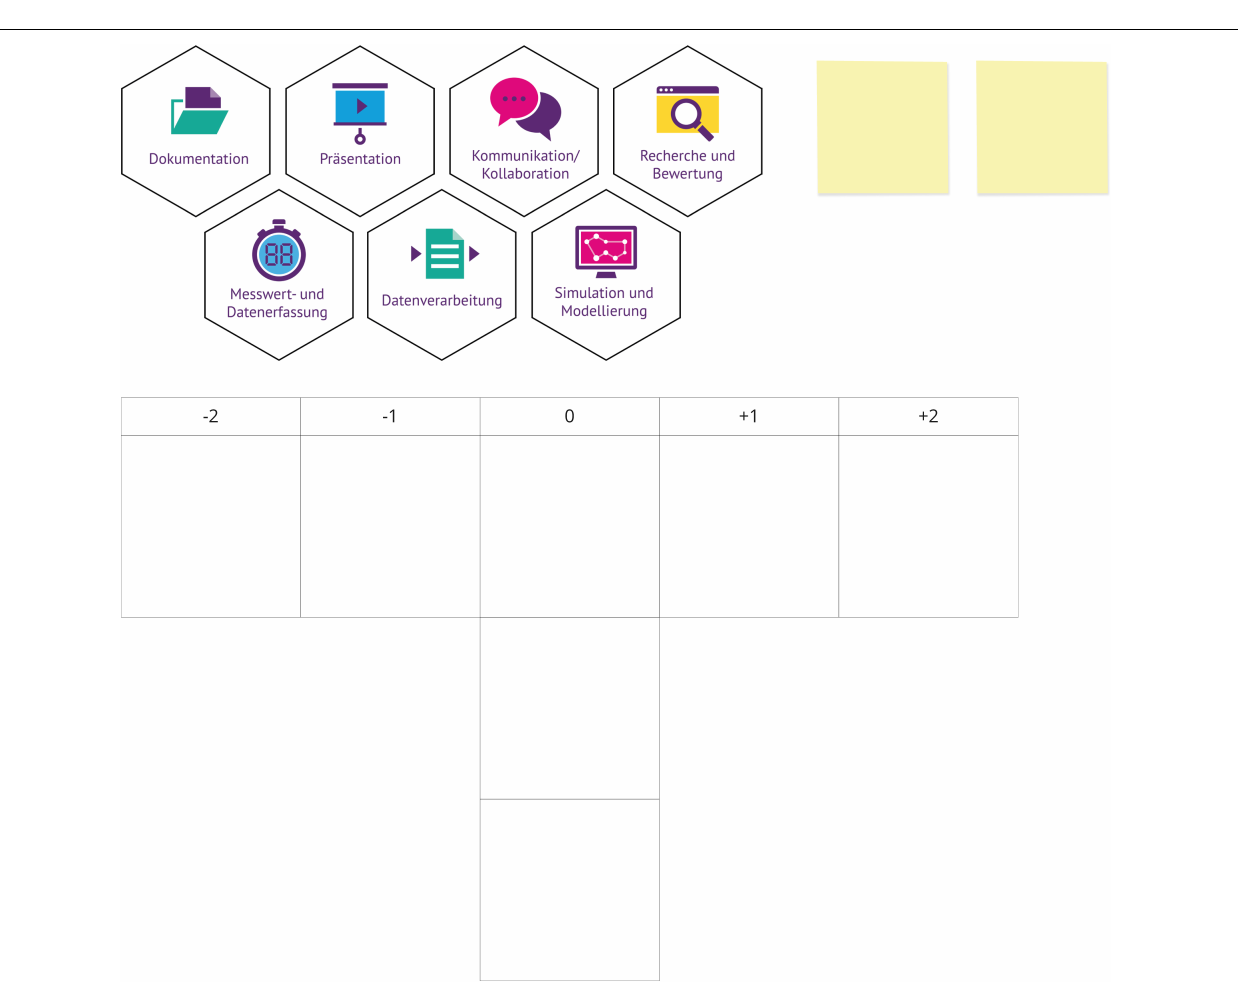
FIGURE 2 | Excerpt from the collaborative online board, with the instructional material for conducting a Q-sort. The seven central competency areas are ordered from –2 = least important to +2 = most important. If necessary, competency areas that the subjects feel are missing can be added as sticky notes.